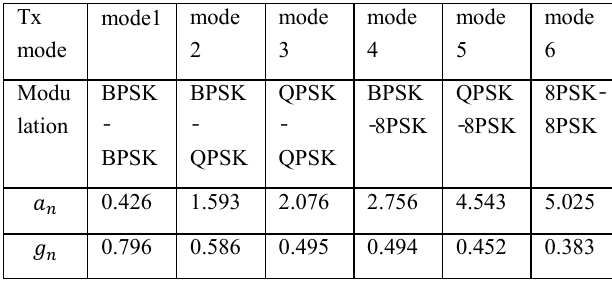
Table 2. PER’s fitting parameters of six transmission modes